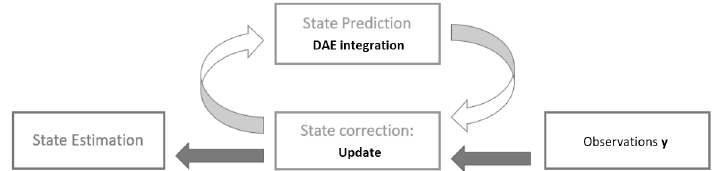
Figure 3. Kalman filter scheme based on the prediction-correction